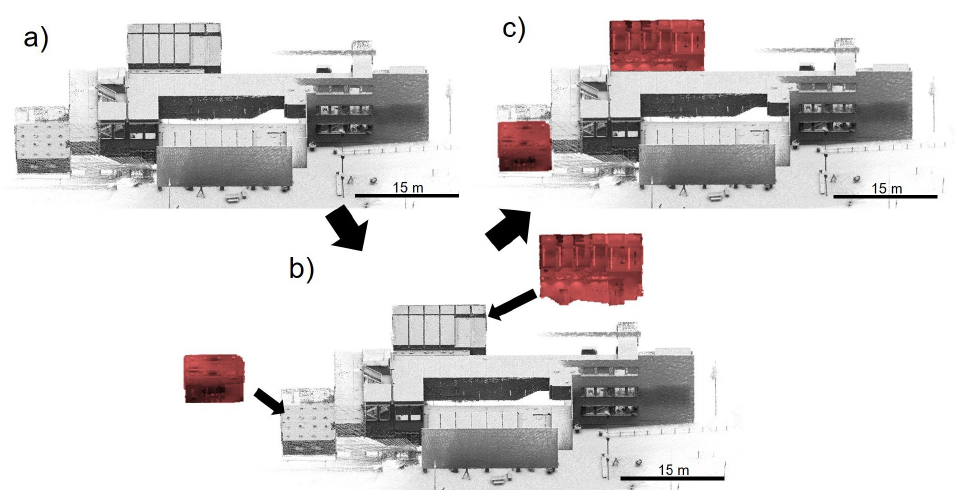
Figure 2. ( a ) A SLAM LS point cloud, ( b ) registering TLS rooms (depicted in red) to the SLAM LS point cloud and ( c ) the TLS rooms registered with the support of the SLAM LS point